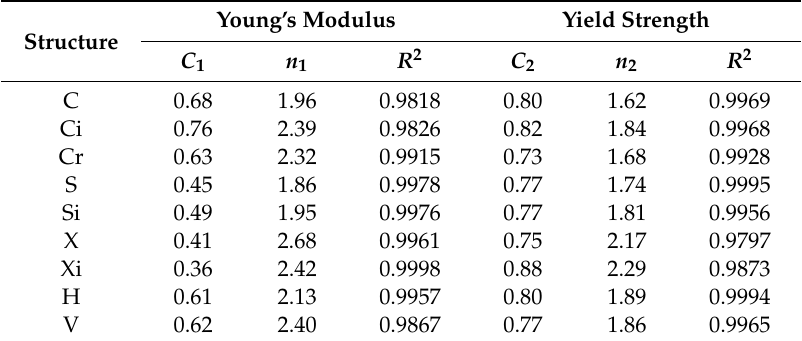
Table 3. Parameters of the Gibson–Ashby models for Young’s modulus and yield strength of different structures investigated.